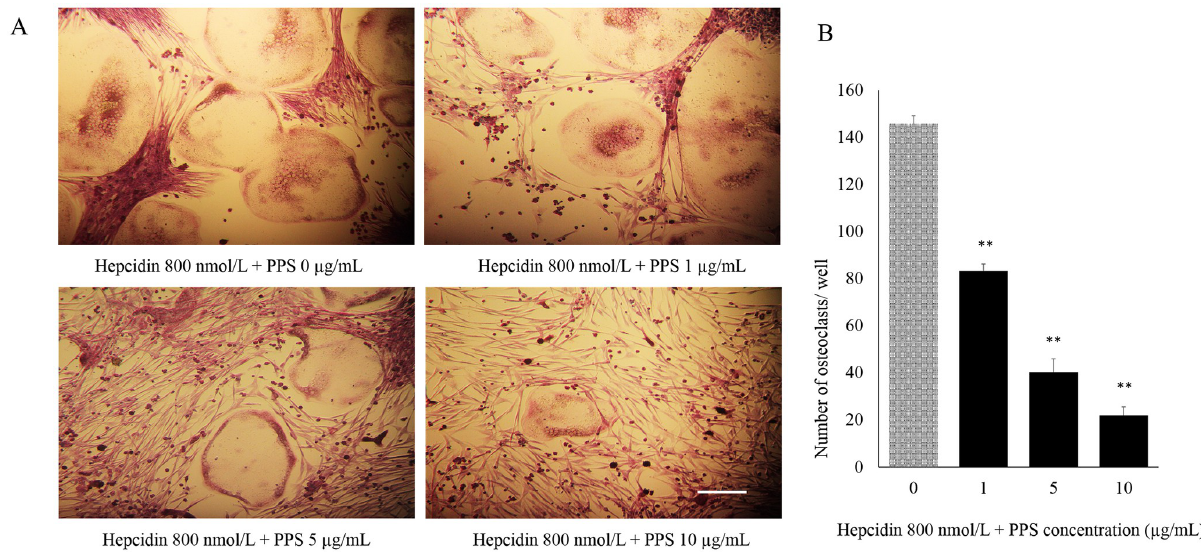
Fig 3. Inhibitory effect of PPS on OC treated with hepcidin 1. The cells were treated with various concentrations of PPS followed by 800 nmol/L hepcidin 1, M-CSF (20 ng/mL) and RANKL (50 ng/mL) for 7 days. (A) The cells were stained for TRAP stain and TRAP-positive cells ( � 3 nuclei) were counted. Scale bar- 200 μ m. (B) Bar graphs show the number of OC cells/well. Data are representative of three independent experiments and expressed as means ± SE. Means with � are significantly different from 0 μ g/mL of PPS ( � p < 0.05, �� p < 0.01).